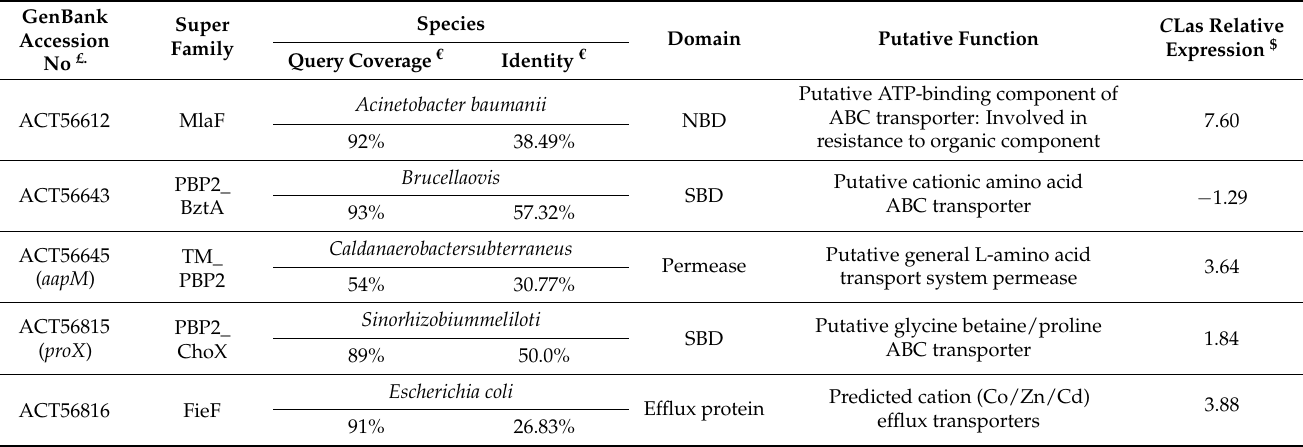
Table 4. ABC transporter system of C